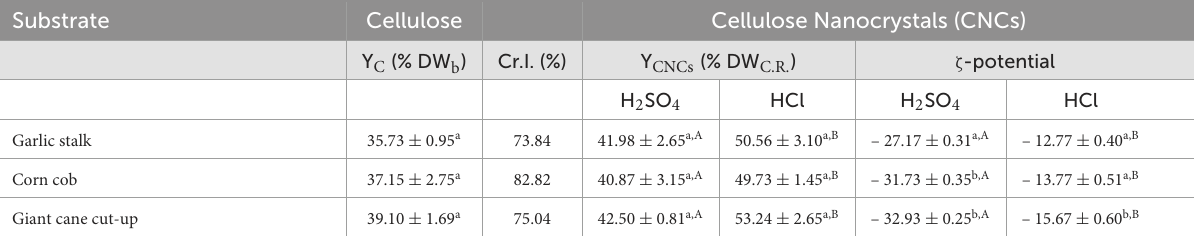
TABLE 2 Yield and Cr.I. of cellulose and yield and ζ -potential of CNCs extracted from garlic stalk, corncob, and giant cane cut-up. Substrate